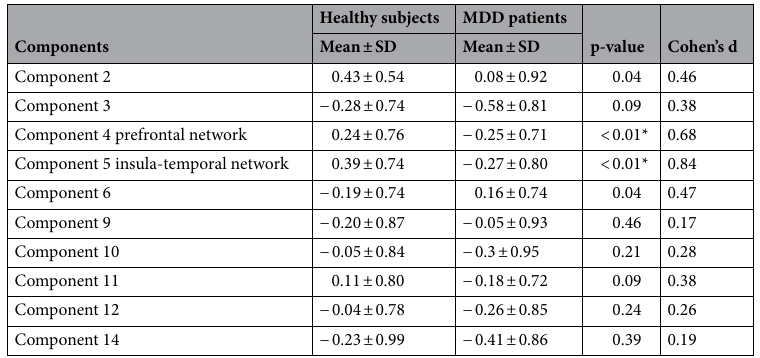
Table 2. Differences in the loading coefficient of independent components. SD, standard deviation, MDD, Major depression disorders. *Significant difference after Bonferroni correction.